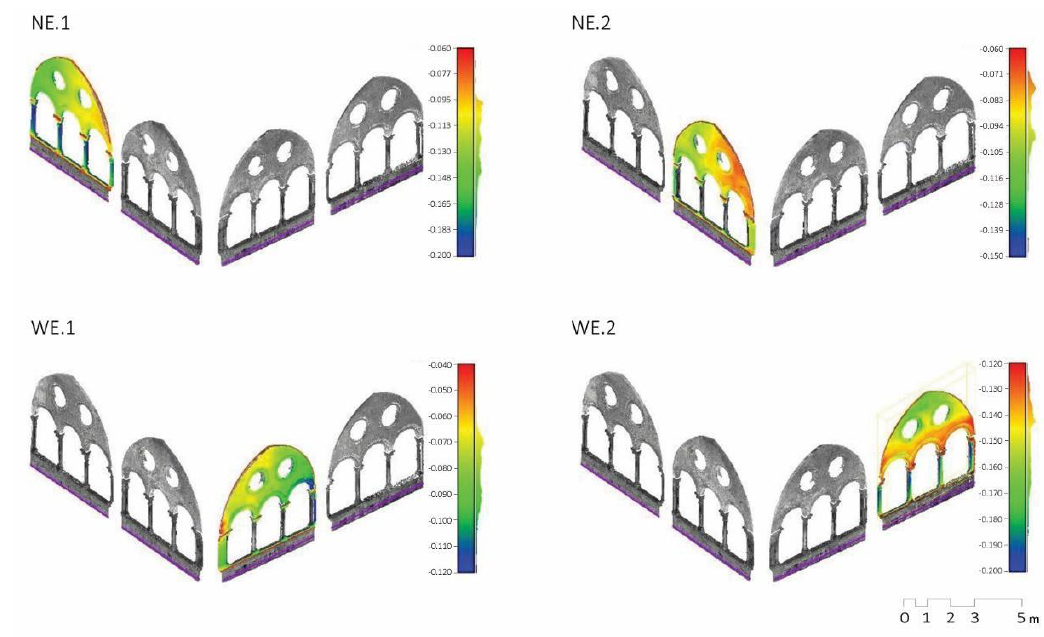
Figure 9. Distance maps of inner north wall (units in meters).